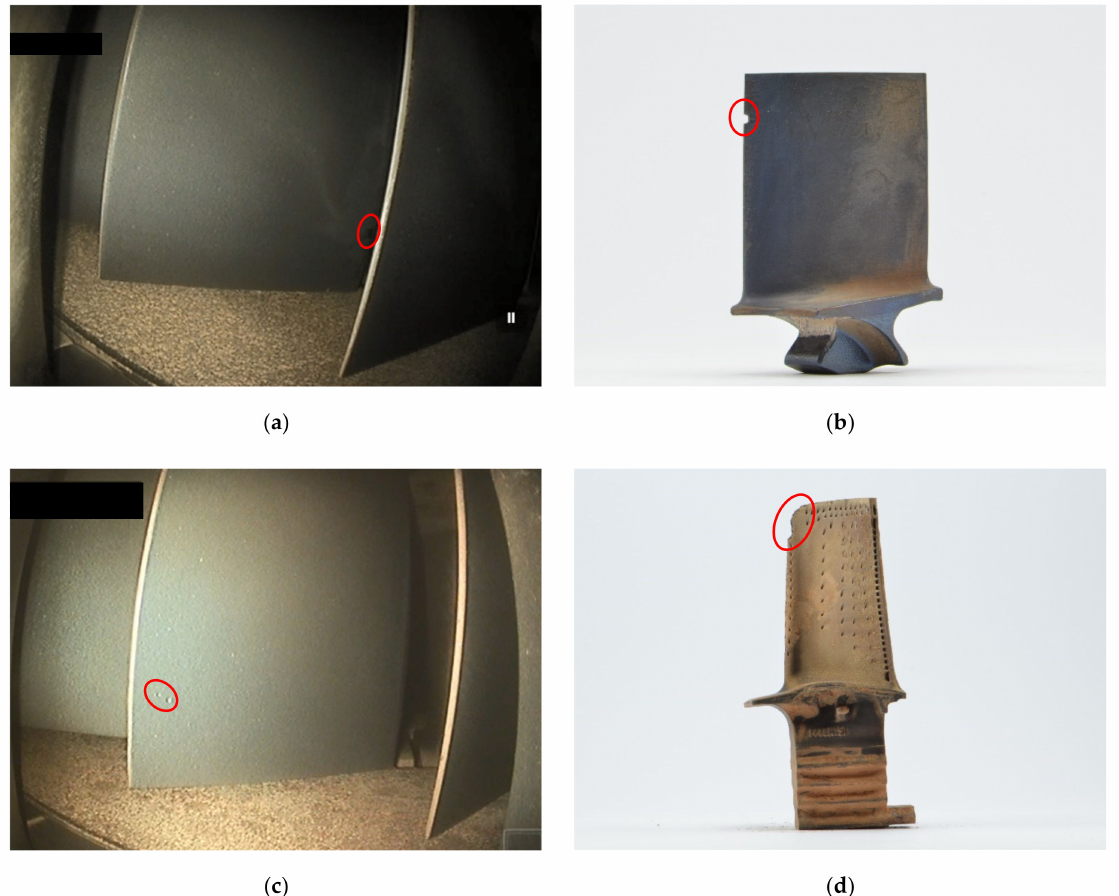
Figure 9. Sample blades with different defects highlighted with red markings. ( a ) Borescope image of high-pressure compressor (HPC) stage 8 blade with nick on leading edge. ( b ) Same blade as in ( a ) but this time presented as during on-bench piece-part inspection. ( c ) Airfoil dents on an HPC stage 8 blade in boroscopic view. ( d ) Broken-off leading edge corner of a high-pressure turbine (HPT) stage 1